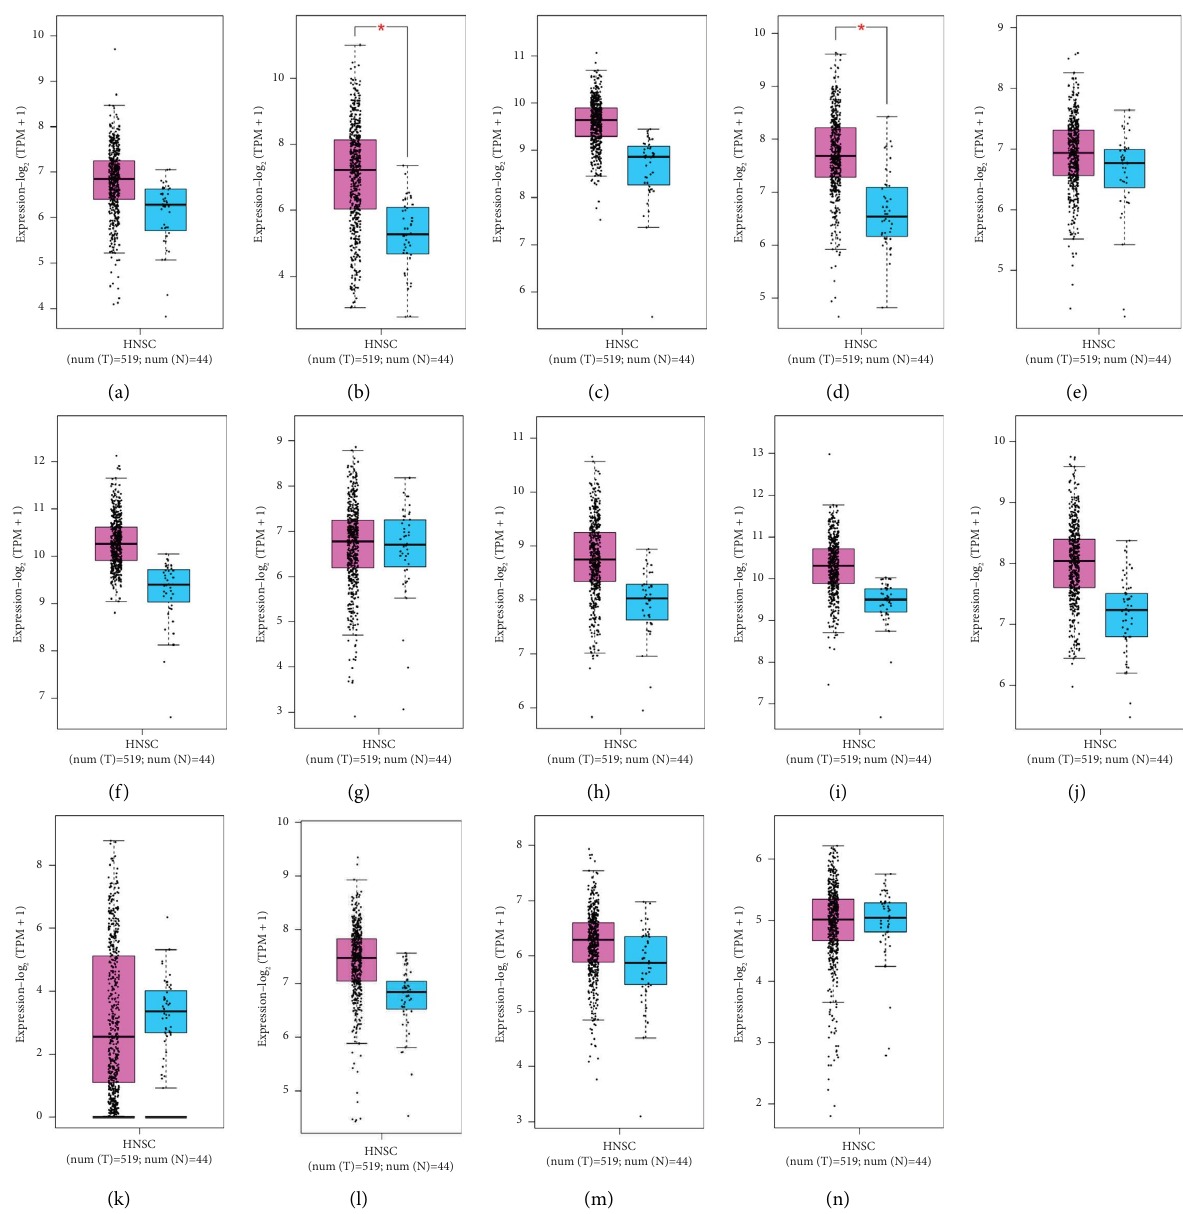
Figure 6: Gene expression patterns of prognostic markers in HNSCC including (a) EIF2S1, (b) CAV1, (c) RAN, (d) ANXA5, (e) CYCS, (f) CFL1, (g) MYC, (h) HSP90AA1, (i) PKM, (j) HSPA5, (k) NTRK2, (l) HNRNPH1, (m) DDX17, and (n) WDR82. Box plots are based on 519 HNSCC tissues (pink color) and 44 healthy oral tissues (blue color). HNSCC, head and neck squamous cell